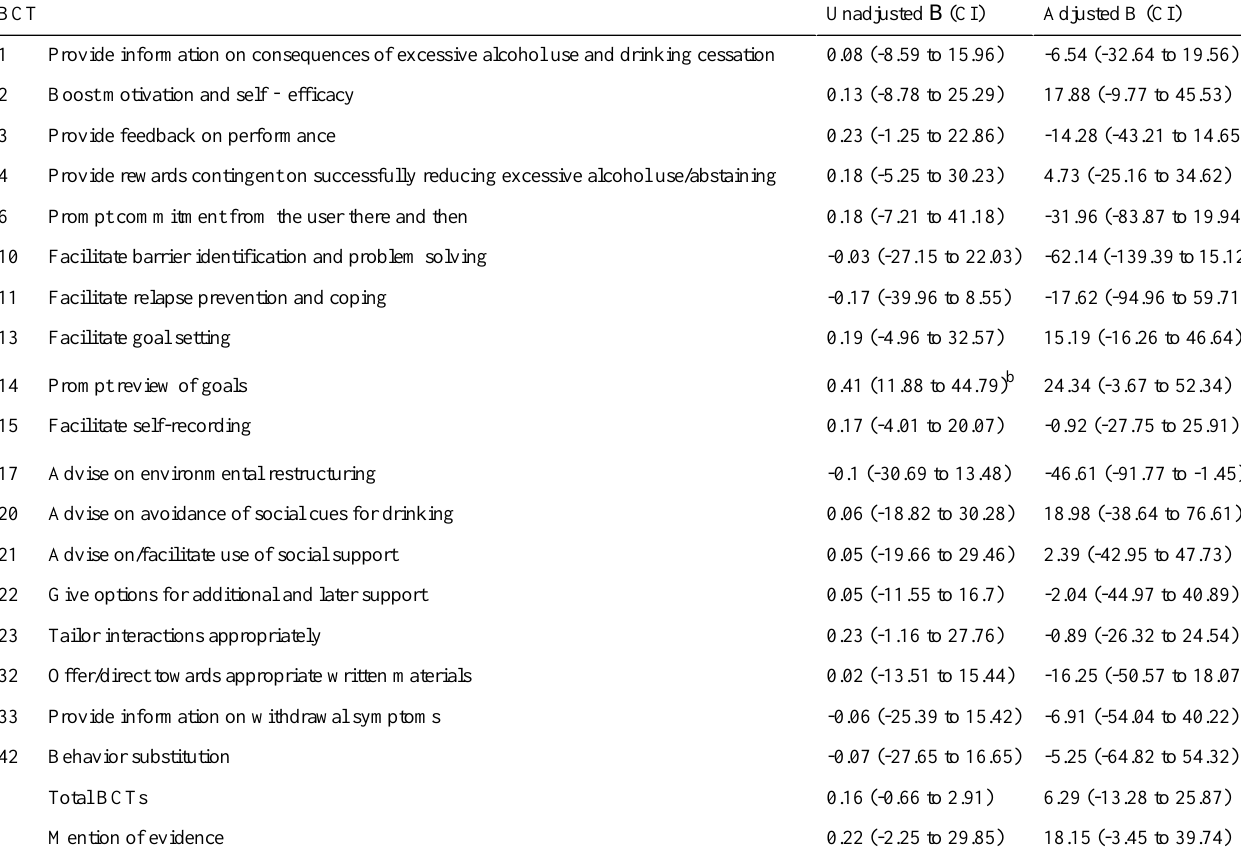
Table 2. The association between BCTs, theory/evidence with ratings (lower 95% CI of the proportion of ratings >3/5).